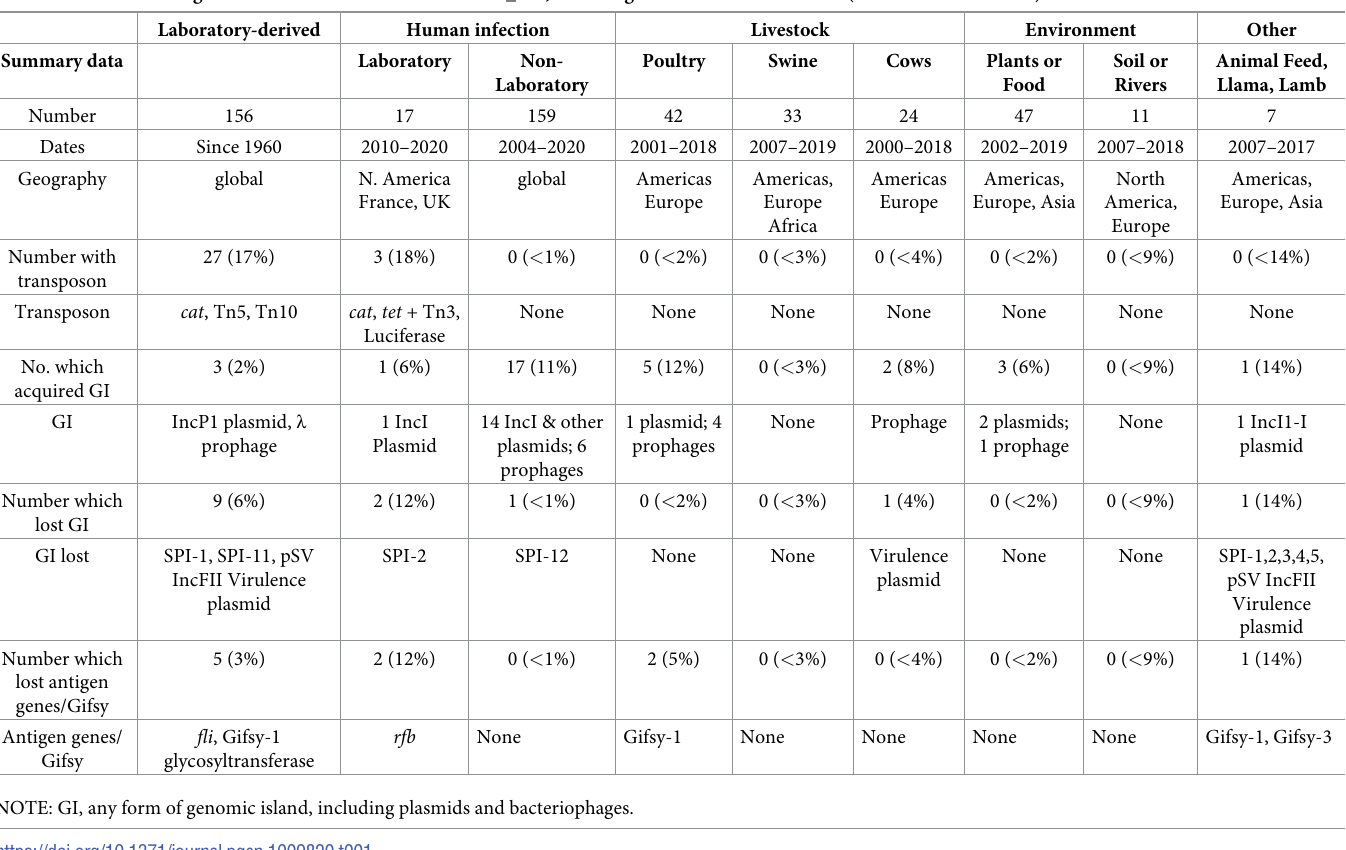
Table 1. Sources of 496 genomes within HierCC cluster HC20_373, including ATCC14028s derivatives (EnteroBase 1/12/2020).